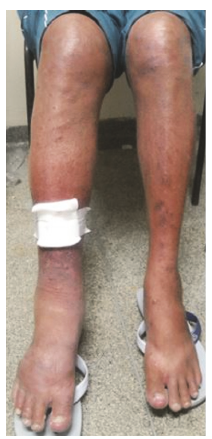
Figure 3: Case 4: patient with edema during acute DVT in right leg.